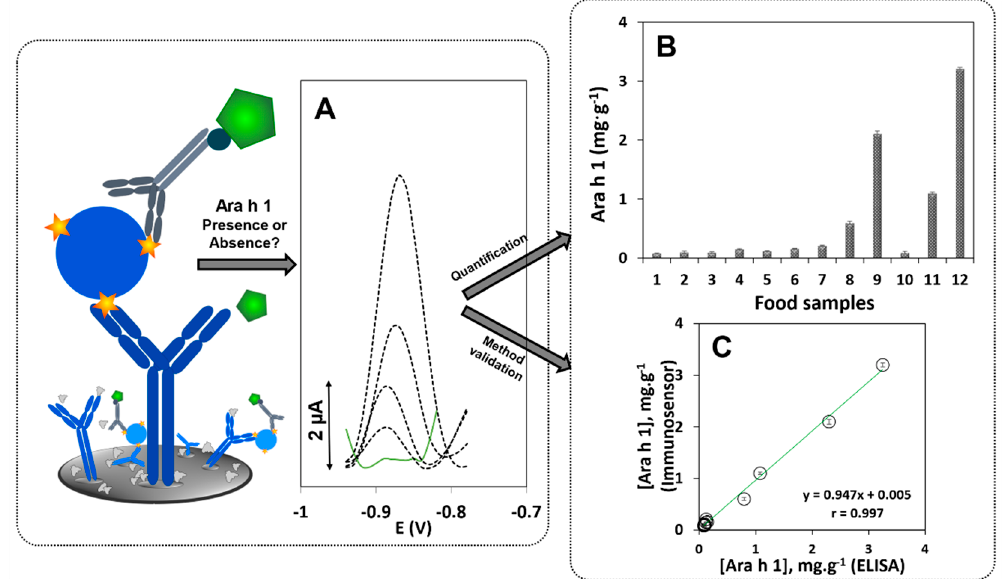
Figure 6. Analysis of food products. ( A ) DPASV voltammograms (dashed line—presence of Ara h 1, solid line—absence of Ara h 1); ( B ) Results of the determination of Ara h 1 in the tested products using the immunosensor; ( C ) Correlation plot between the results of the immunosensor and the ELISA kit. (1) soybean, (2) lupin, (3) almond, (4) sesame, (5) wheat flour, (6) hazelnut, (7) gluten- and allergen-free cookie, (8) cookie that “may contain traces of peanuts”, (9) peanut cookie, (10) cereal bar (No peanut), (11) protein bar, containing 5.5% of peanut, (12) protein bar, containing 12% of peanut.